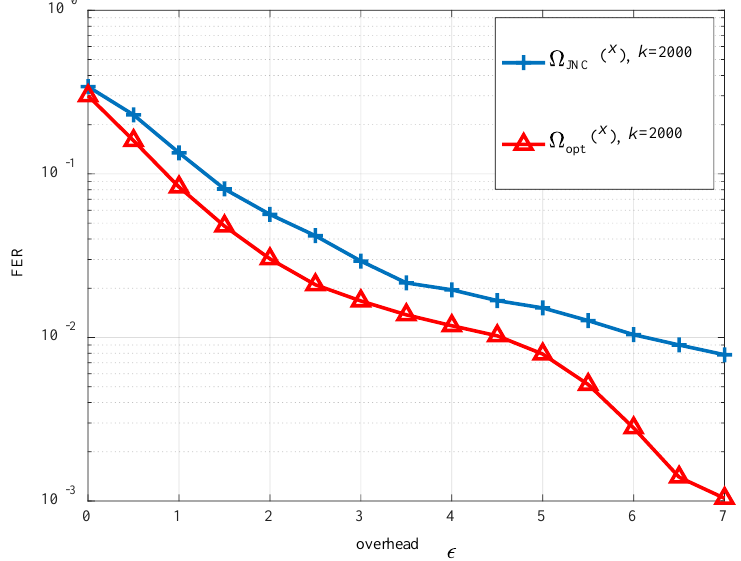
Figure 6. Frame error rate (FER) performance of systematic Luby transform (SLT)-coded multiply-and-forward two-way relay network (MF-TWRN) using different degree distributions with =2000 k .